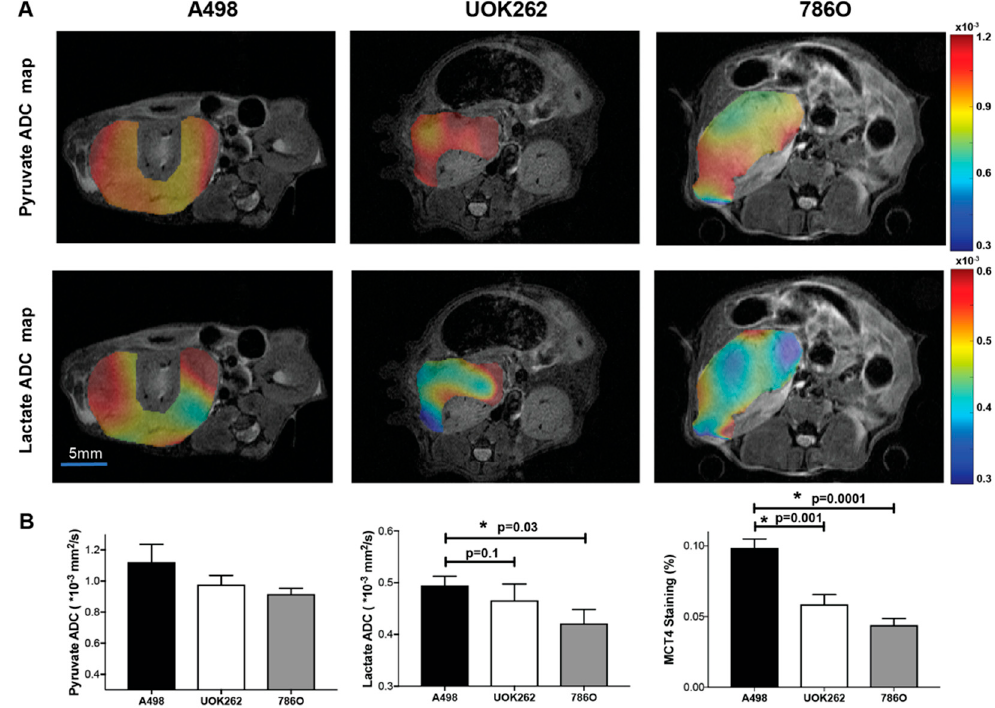
Figure 4. Diffusion-weighted HP 13 C MRI to interrogate 13 C lactate compartmentalization in orthotopic RCC tumors (A-498 ( n = 8), UOK262 ( n = 7), and 786-O ( n = 8) tumors). ( A ) Representative 13 C